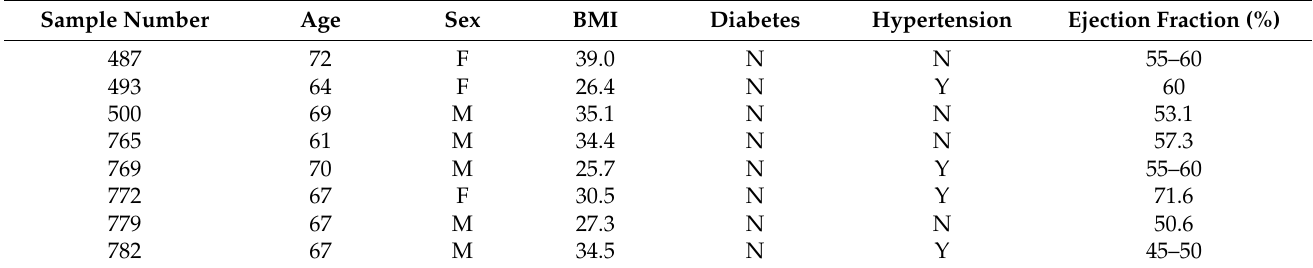
Table 1. Patient